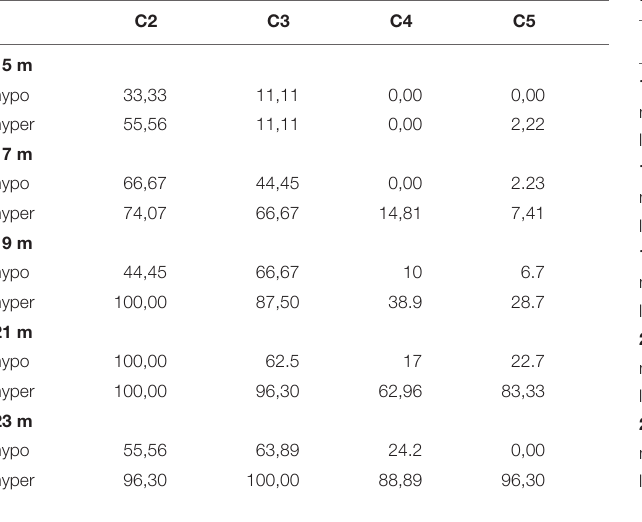
TABLE 2 | Mean percentage of success among premature children as a function of muscle tone and age. TABLE 3 | Mean percentage of success among premature children as a function of prematurity and